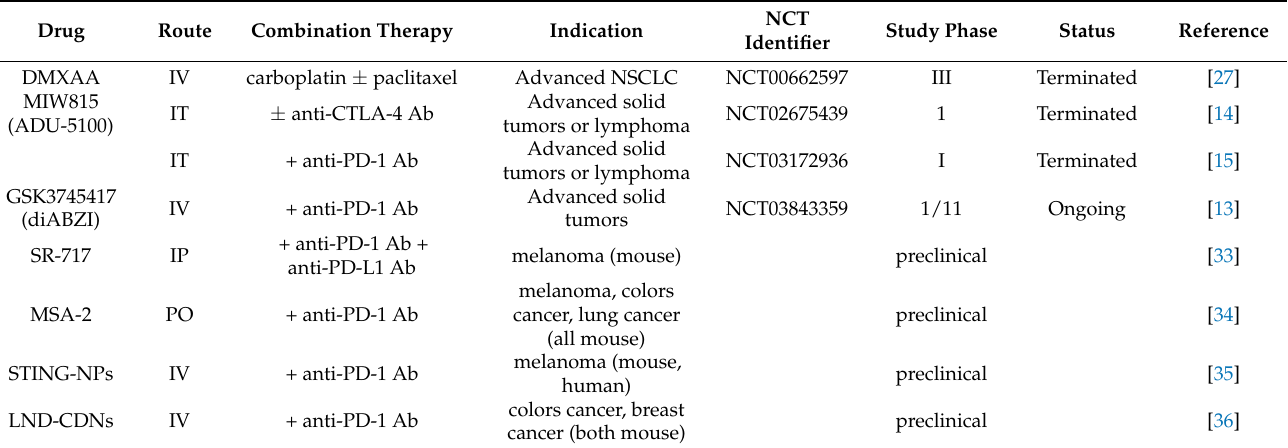
Table 1. Clinical trials of Sting agonist and future STING